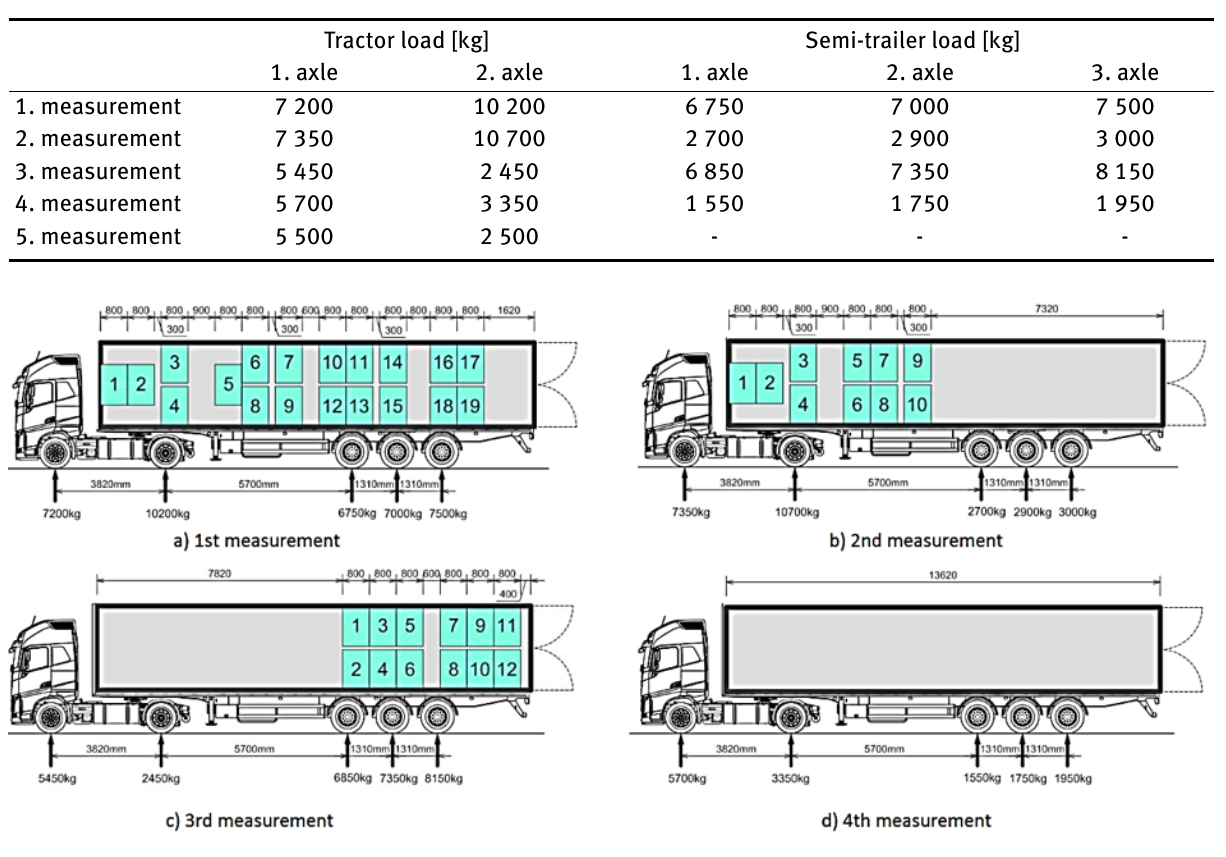
Figure 1: Load distributions: a) Measurement No. 1; b) Measurement No. 2; c) Measurement No. 3; Measurement No.